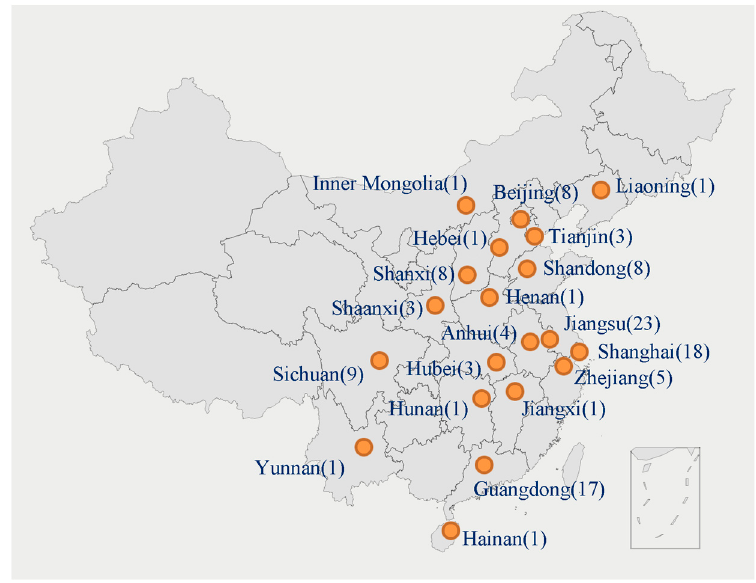
Figure 4. Distribution of investigated container project cases around China.